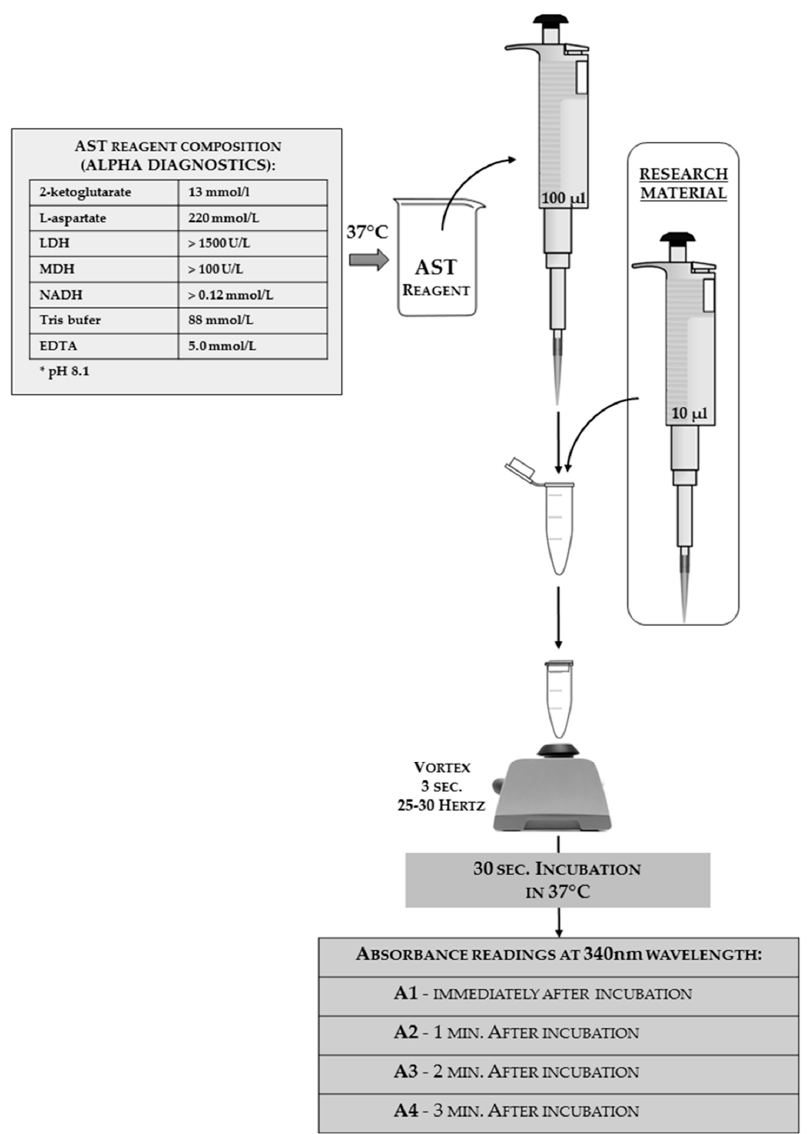
Figure 11. The scheme of aspartate aminotransferase (AST) activity analyses adjusted for